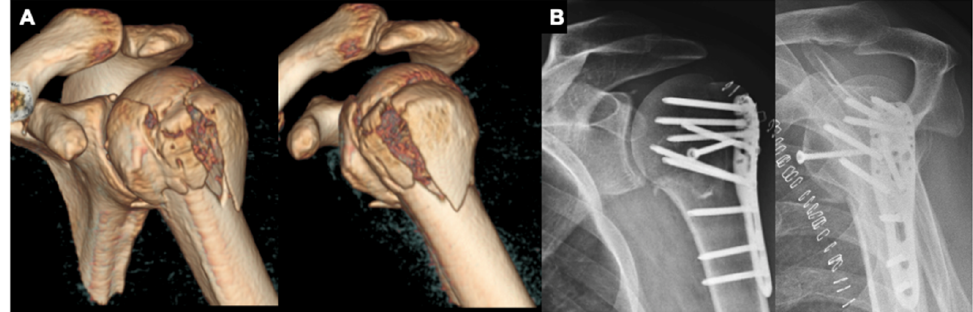
Figure 1. ( A , B ): 57-year-old male patient with a varus-impacted 4-part proximal humeral fracture with headsplit treated with a PHILOS plate (DePuy Synthes ® , Umkirch, Germany) and additional free humeral head screw.